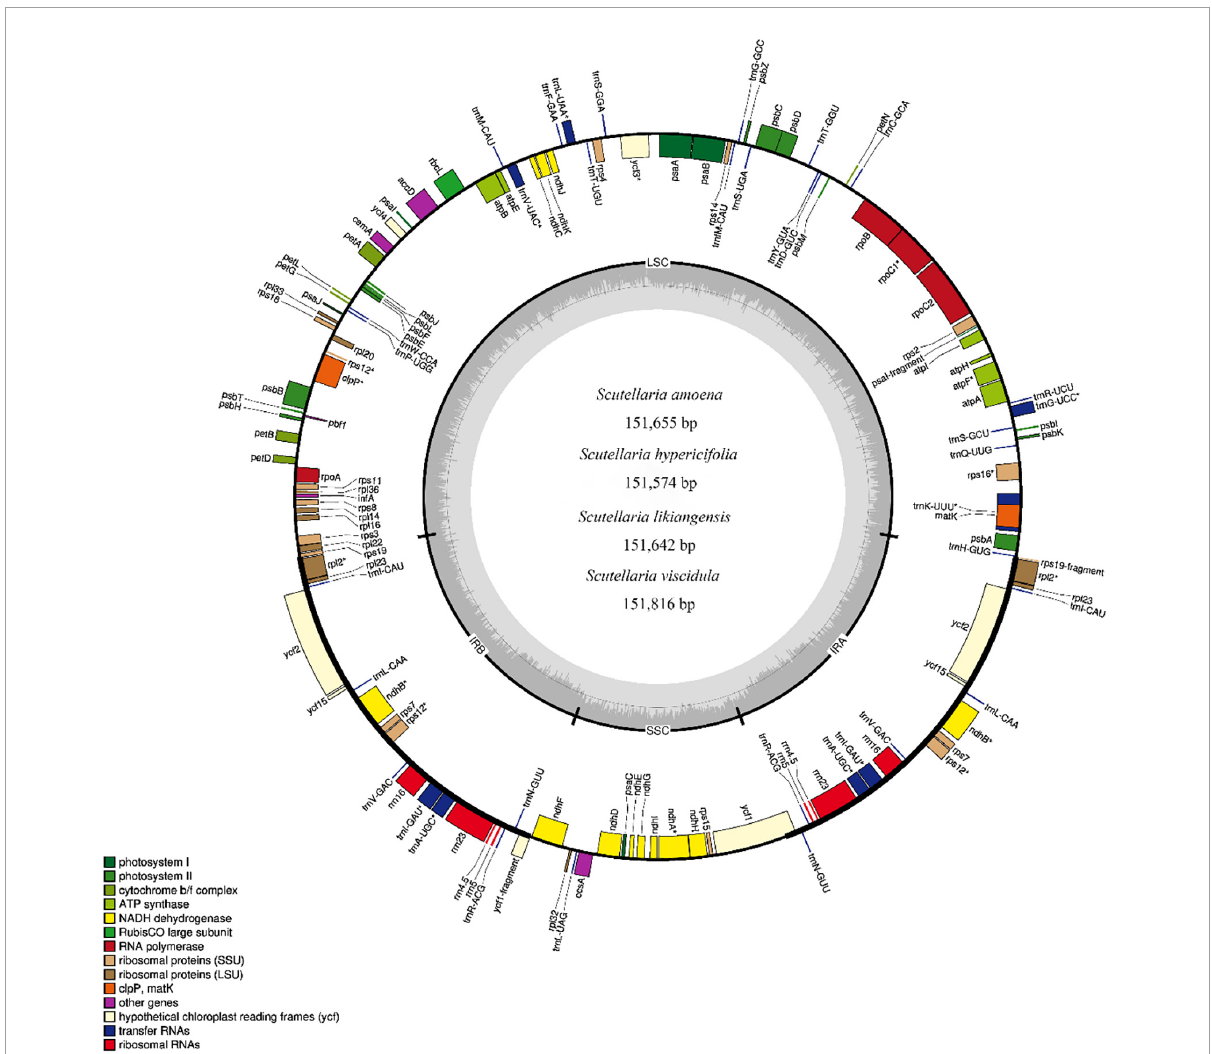
FIGURE1 Gene map of the complete cp genomes of S. amoena , S. hypericifolia , S. likiangensis, and S. viscidula . Only one map is shown here due to the negligible differences among the four species. Genes inside the circle are transcribed clockwise, while genes outside the circle are transcribed counterclockwise. The different colors indicate different functional groups of genes. Dark gray areas inside the circle indicate the GC content, while light gray areas indicate the AT content of the